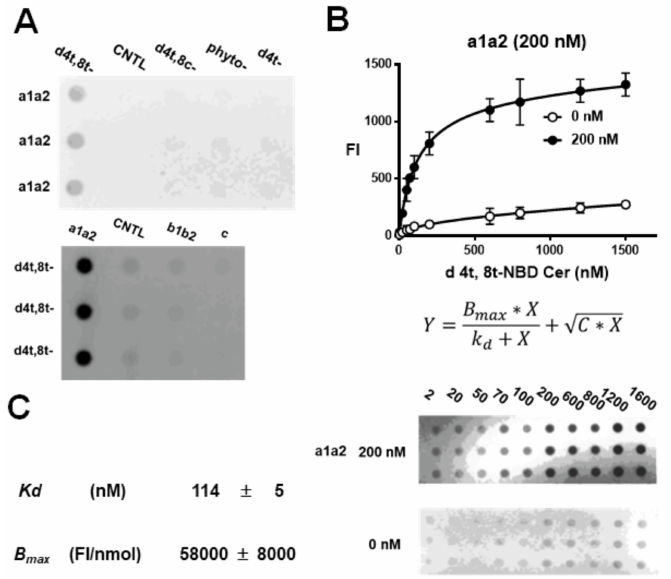
Figure 4. Dot blot analysis of the binding characteristics of kCer to Nrp1 domain proteins. ( A ) The upper blot shows the results for mixtures a1a2 (of 100 nM) plus d4t,8t-NBD-Ceramide (-NBD-Cer), d4t,8c-NBD-Cer, phyto-NBD-Cer, or d 4t-NBD-Cer (all at 100 nM). The lower blot shows the results for mixtures of 100 nM d4t,8t-NBD-Cer with 100 nM a1a2, b1b2, or b. ( B ) Saturation curve of